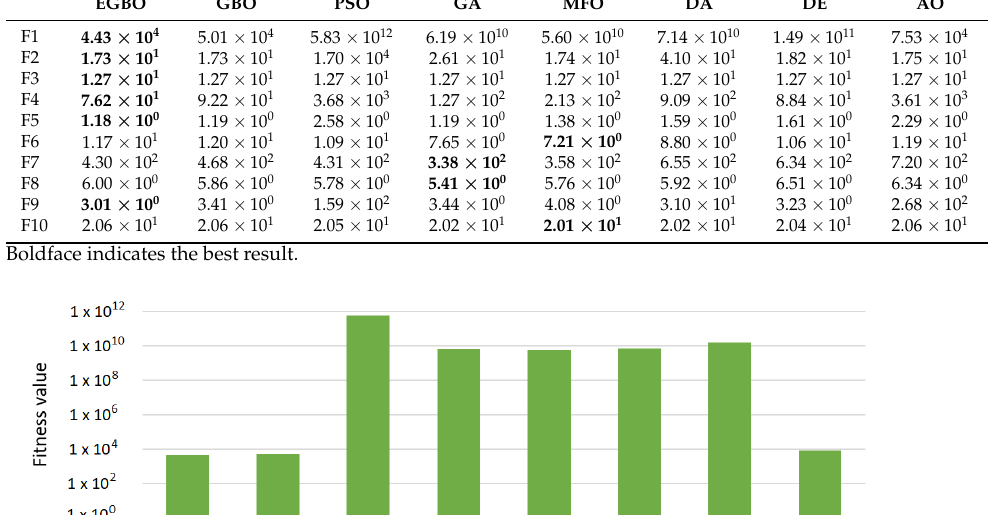
Table 1. Results of the average measure of the fitness function values. EGBO